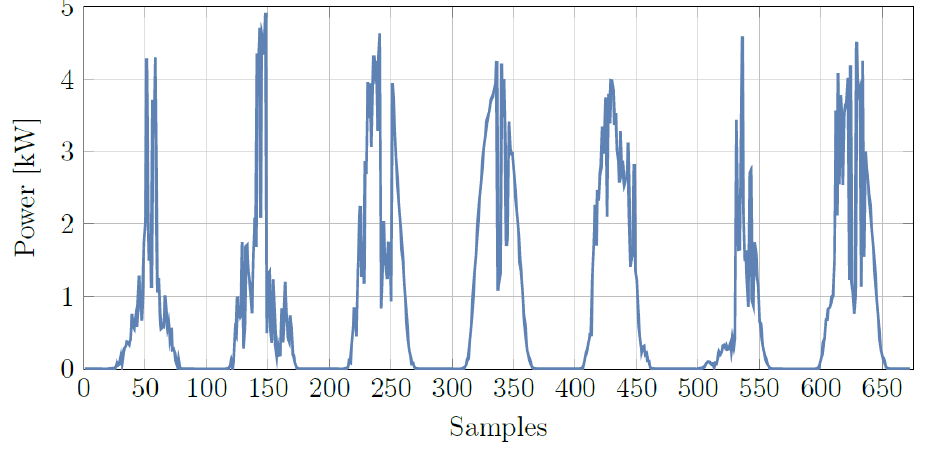
Figure 5. Trends of produced power referred to spring period from 26 April 2020 to 2 May 2020. Days show significant irregularity and the produced power is not characterized by typical profiles.